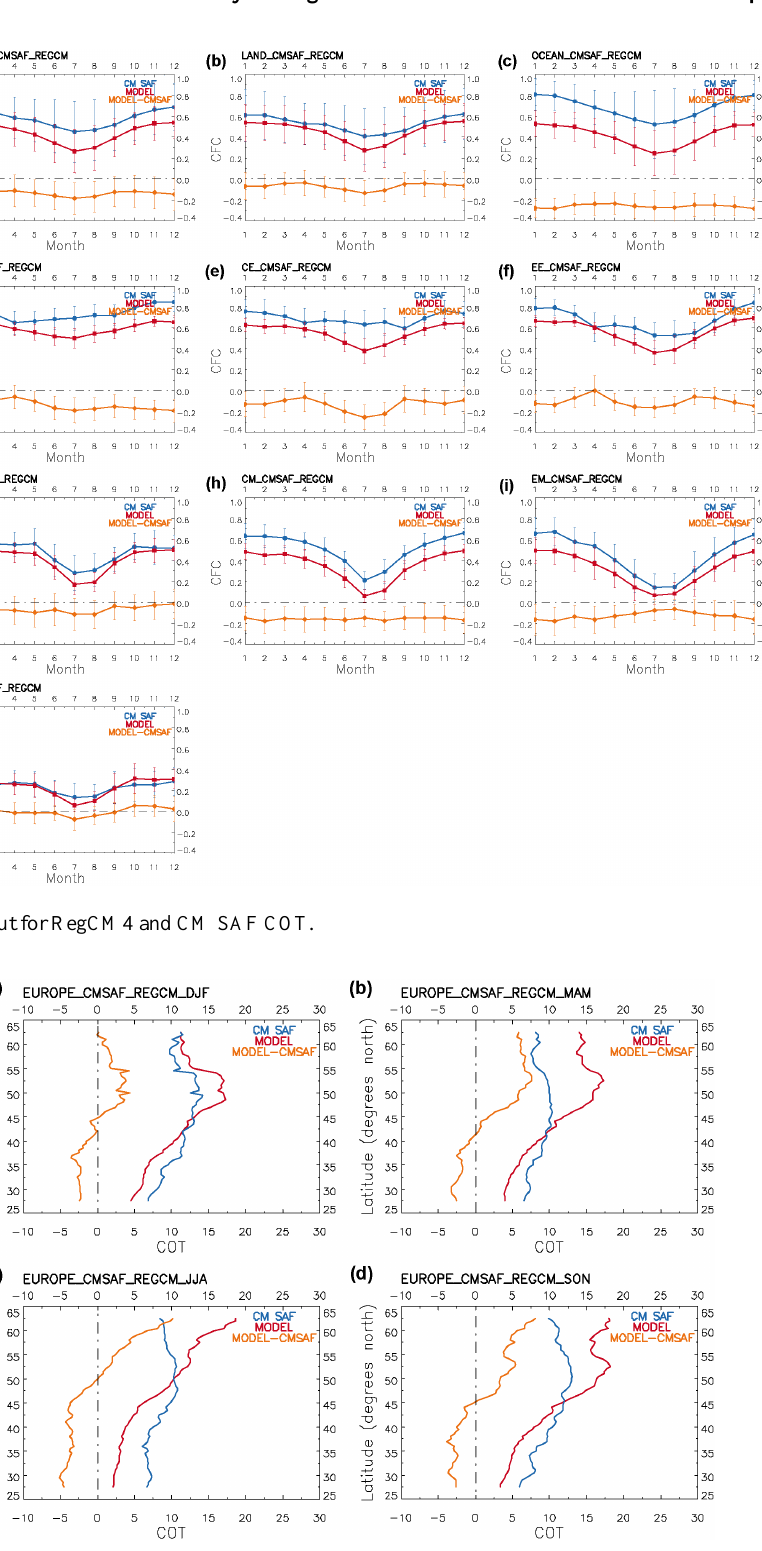
Figure 8. The same as Fig. 2 but for RegCM4 and CM SAF